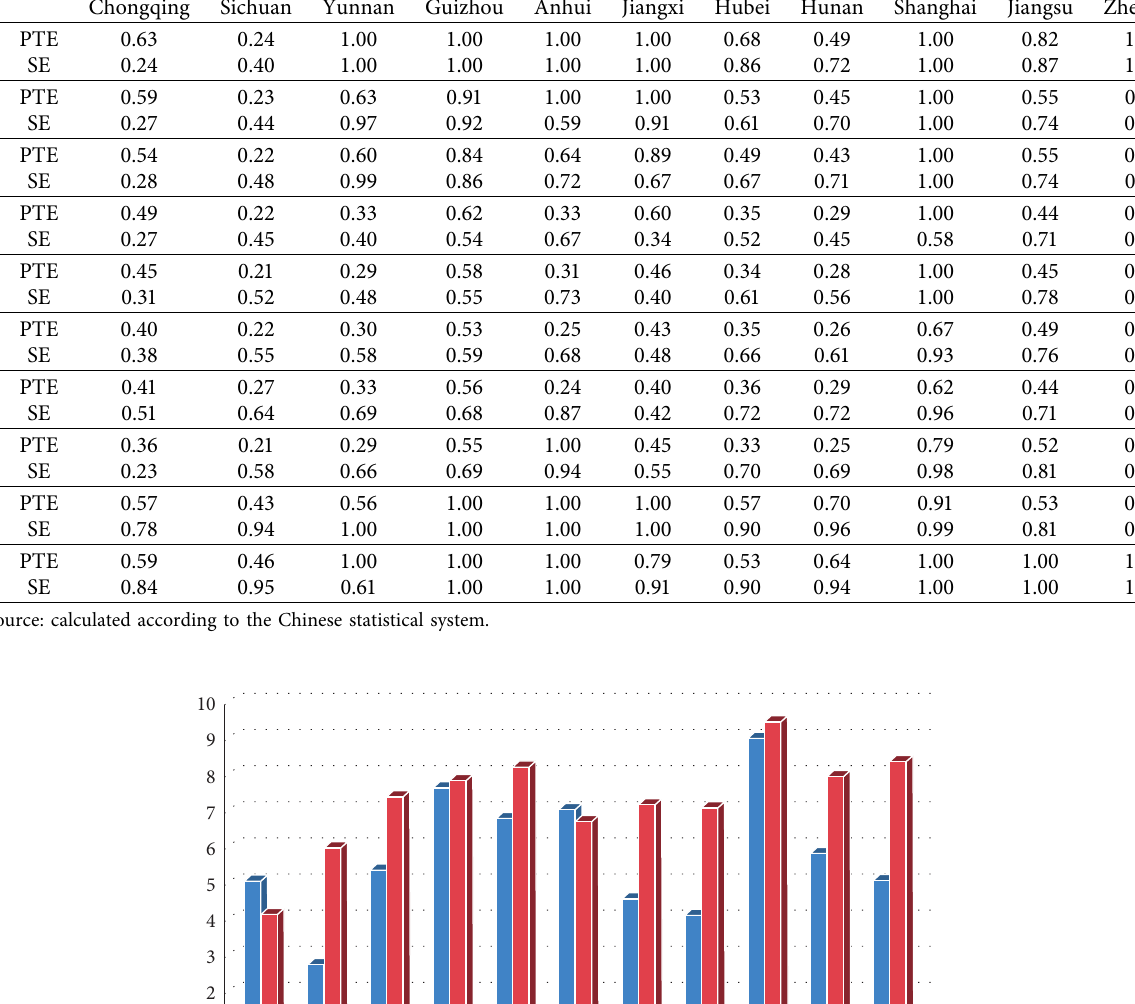
Table 4: PTE and SE of the logistics industry in 11 provinces and cities in the Yangtze River Economic Belt from 2010 to 2019. Year